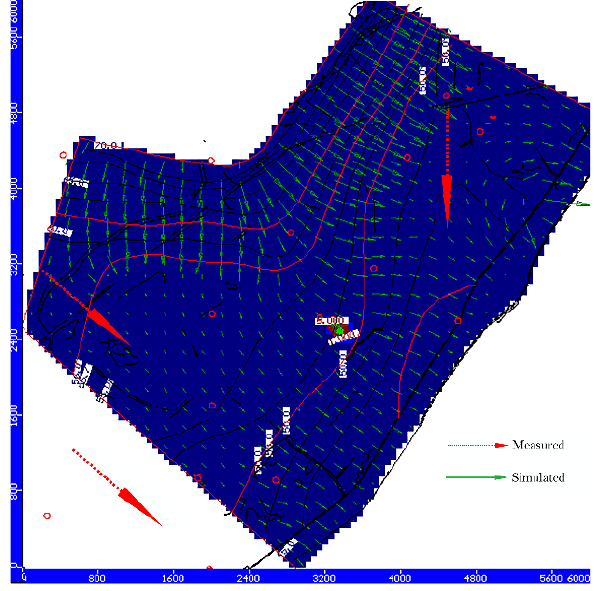
Figure 7. Comparison of the simulated flow net with field survey data.